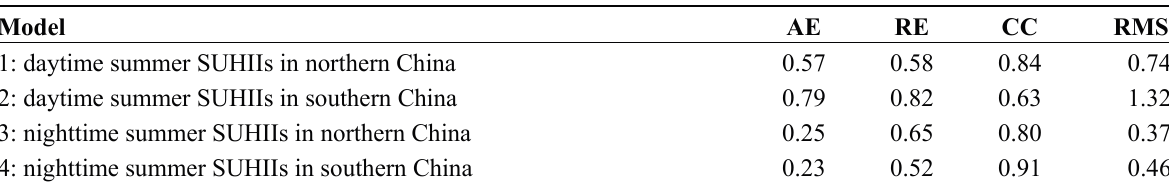
Table 4. Accuracy statistics for each SUHII model.AE: average error; RE: relative error; CC: correlation coefficient; RMSE: root mean square error.